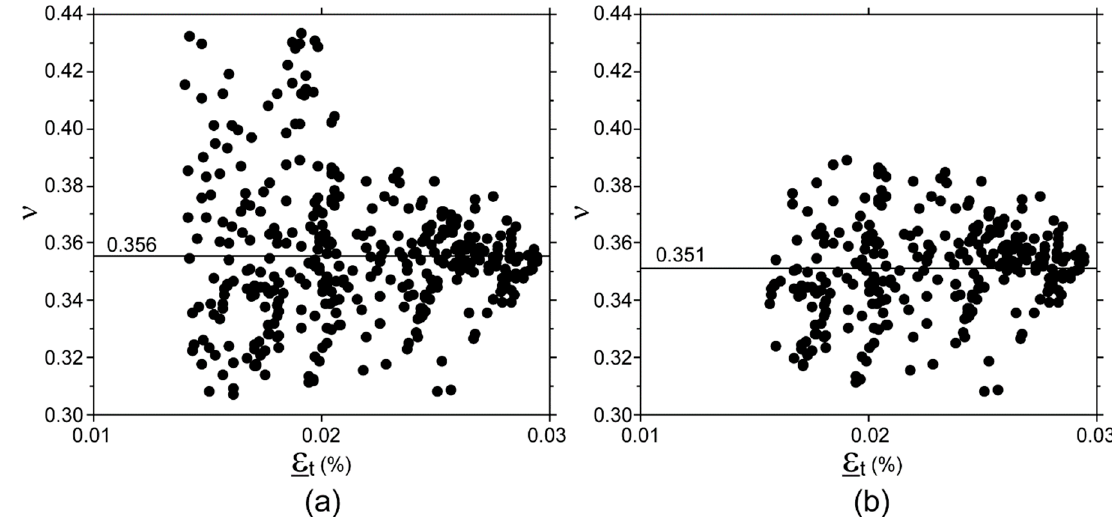
Figure 6. ν mean value determined for one specimen. ( a ) Data obtained using a subset size of 60 × 60 pixels. ( b ) Data obtained using a subset size of 60 × 60 pixels and image pre-selection. Note 1: The 140 microstrain threshold to ε t had already been applied before calculating ν values reported in this graph. Note 2: Interchanging ε l to ε t in x -axis would: (i) scale the x -axis by a factor of 1/0.35 (ii) cause a small horizontal drift of each point, the entity and direction of which would depend on the difference between the current value and 0.35; no changes would occur in ν mean values.